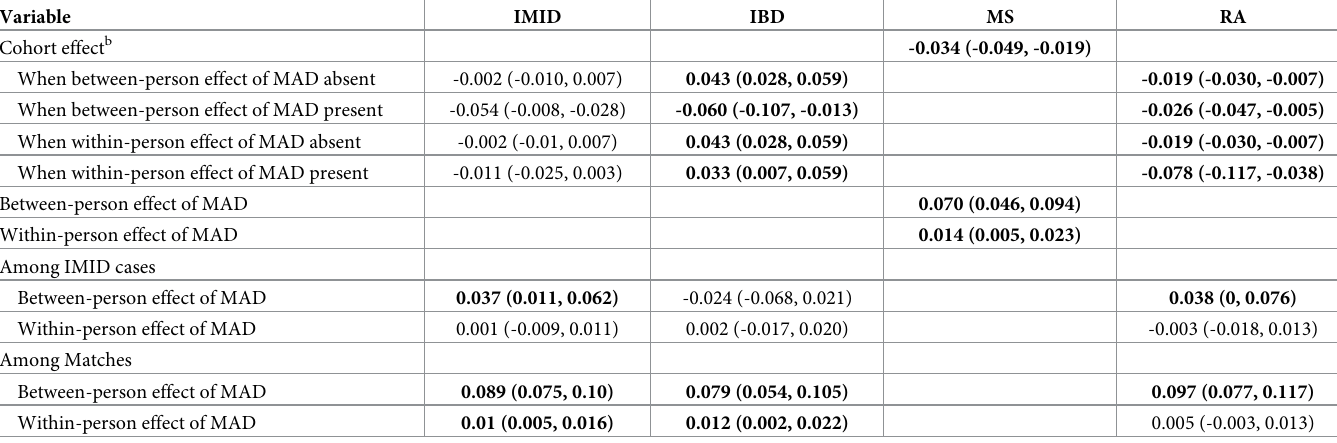
Table 3. Adjusted a association of immune-mediated inflammatory disease (IMID), any mood or anxiety disorder (MAD) and pap testing (proportion; 95% confi- dence